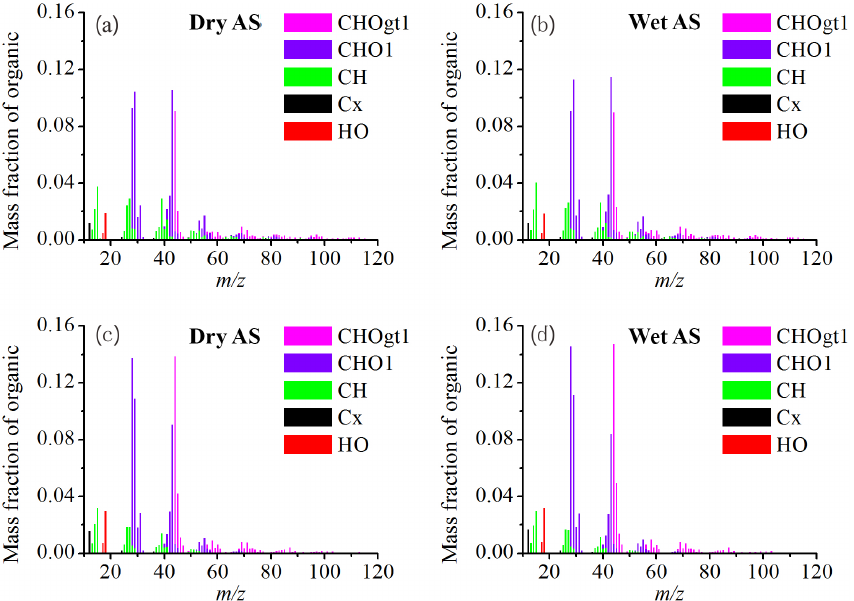
Figure 4. High-resolution mass spectra of toluene-derived SOA on initially wet and dry AS at an OH exposure of (a,